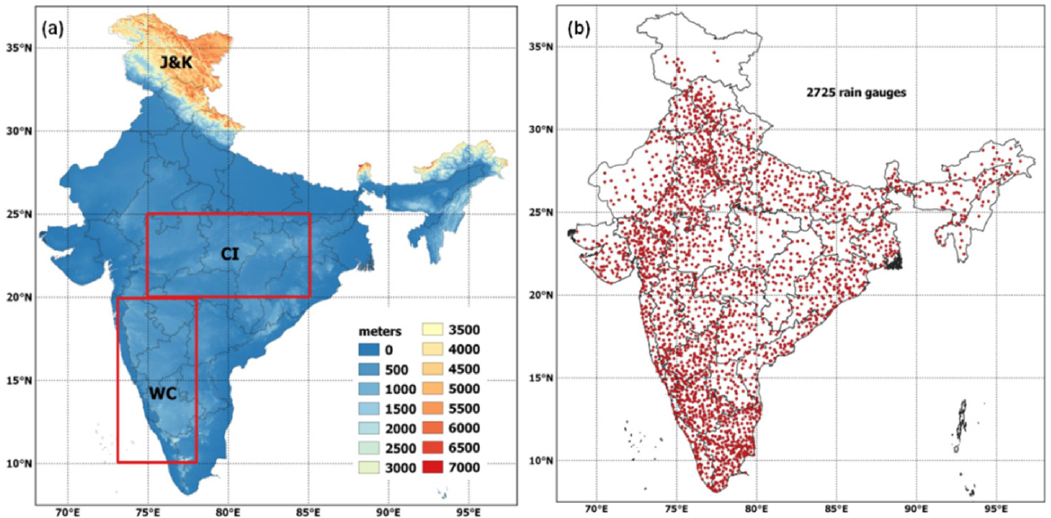
Figure 1. ( a ) Topography (m) distributions across India, and ( b ) locations of 2725 reporting IMD rain gauges for a typical day in July 2014. Two rectangular boxes shown in Figure 1a indicate central India (CI) and west coast (WC) of India considered for detailed analysis.